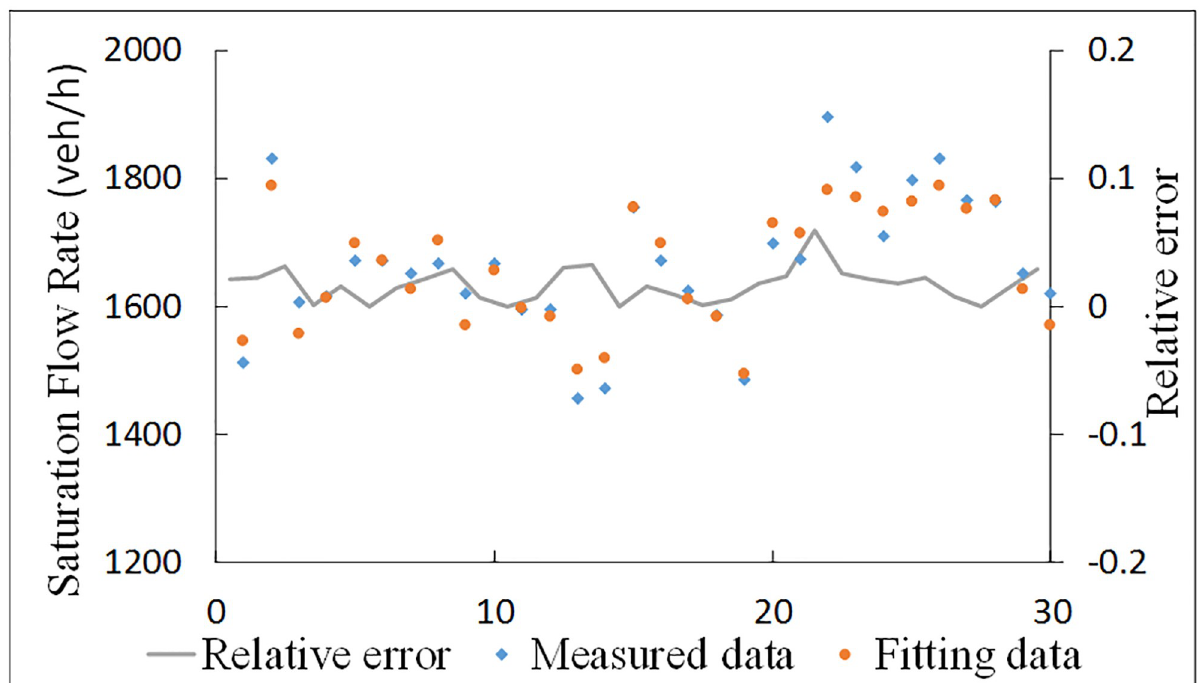
Fig 8. Relative error of correction model for through at the CFI approach.